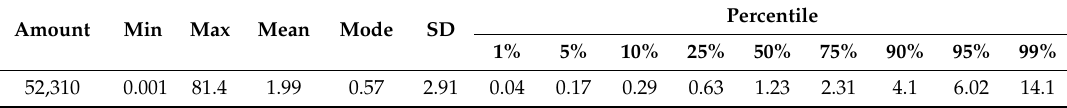
Table 6. Main statistics of the indicator of road density in the